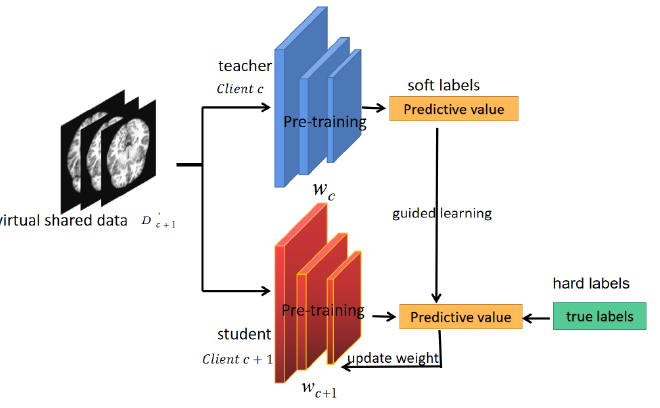
Figure 4. A schematic diagram of the teacher–student guided learning approach.